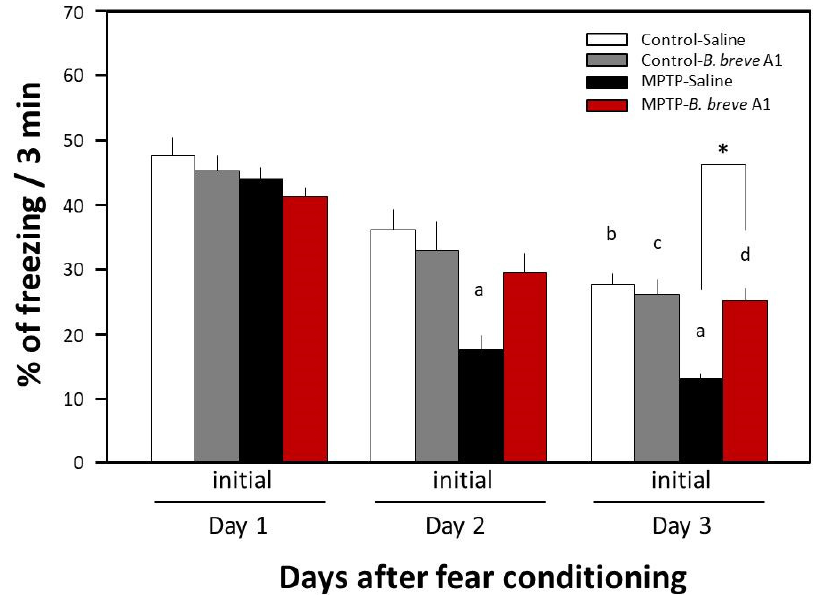
Figure 2. Effects of B. breve A1 on contextual fear extinction in mice. Mice were given oral administration of living B. breve A1 at a volume of 0.2 mL (1 × 10 9 cfu organisms suspended in saline) or saline for 4 days from 3 days before the conditioning day. Data are expressed as the mean ± SEM; n = 6–7. a p < 0.05 vs. MPTP + Saline on Day 1, b p < 0.05 vs. Control + Saline on Day 1, c p < 0.05 vs. Control + B. breve A1 on Day 1, d p < 0.05 vs. MPTP + B. breve A1 on Day 1, and * p < 0.05: between MPTP + Saline and MPTP + B. breve A1 on Day 3.